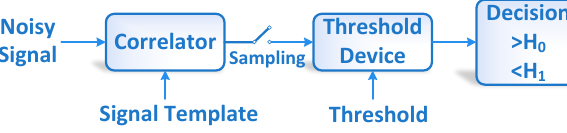
Figure 2. Block diagram of the matched filter